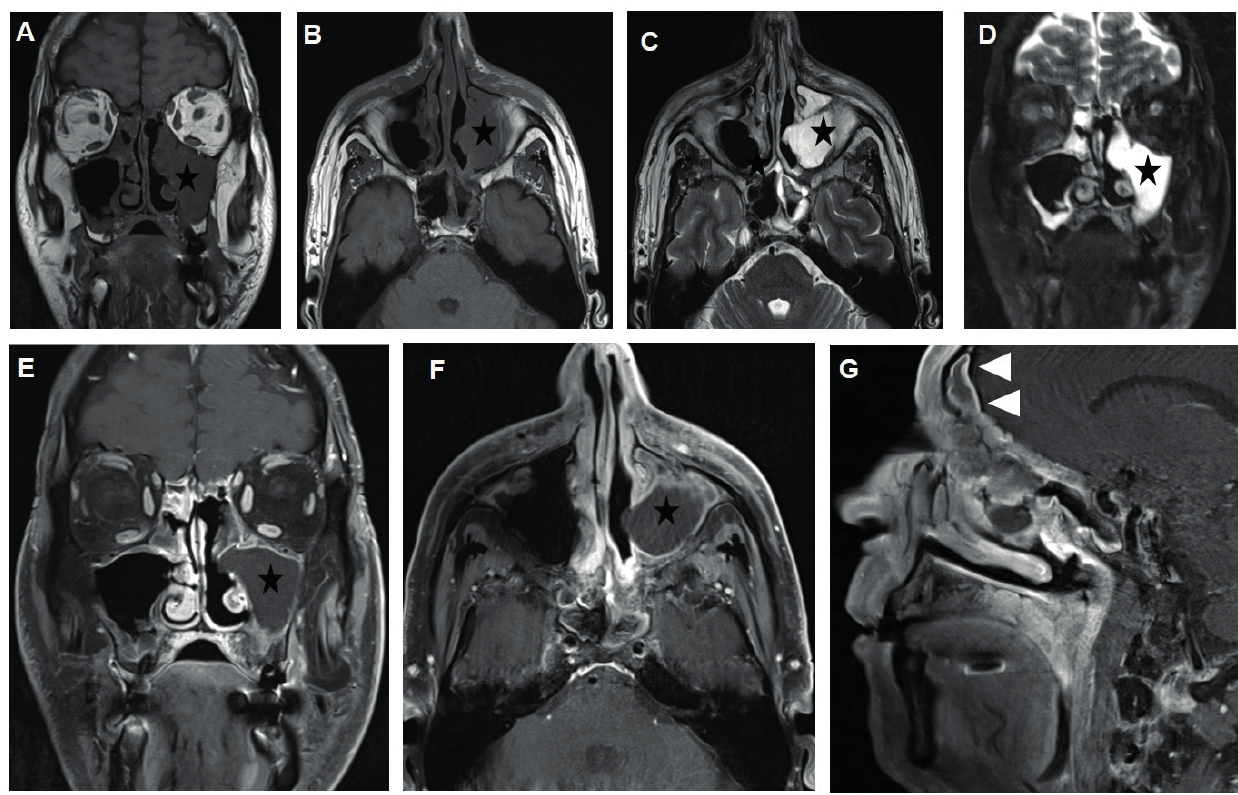
Figure 2. Magnetic resonance imaging restaging examination of the 55-year old patient from Figure 1, three months after a transnasal-transcribriform tumour resection and postoperative proton beam therapy for a sinonasal undifferentiated carcinoma (SNUC). On T1-weighted, non-enhanced coronar (A) and transverse (B) sections, we see a hypointense opacification of the maxillary sinus (black asterix) and partially of the nasal cavity. On T2-weighted, non-enhanced transverse (C) sections and T2-weighted, FS coronar (D) sections, the signal is hyperintense and corresponds most likely to mucus retention in the maxillary sinus (black asterix). On T1-weighted, CE FS coronar (E) and transverse (F) sections, we see a marginal contrast- enhancement of the nasal mucosa, framing the postoperative cavity. The signal of the maxillary sinus (black asterix) is homogenous and hypointense. On T1-weighted, CE FS sagittal (G) sections, there is an inhomogeneous, T1 hypointense contrast enhancement with particular delineation around the frontal recess. The contrast enhancement is predominantly marginal (white arrowhead) and most likely reactive. No evidence of dural and or orbital affection. So far, the patient remained free of disease. CE, contrast-enhanced; FS, fat-suppressed; MS, maxillary sinus; SS, sphenoid